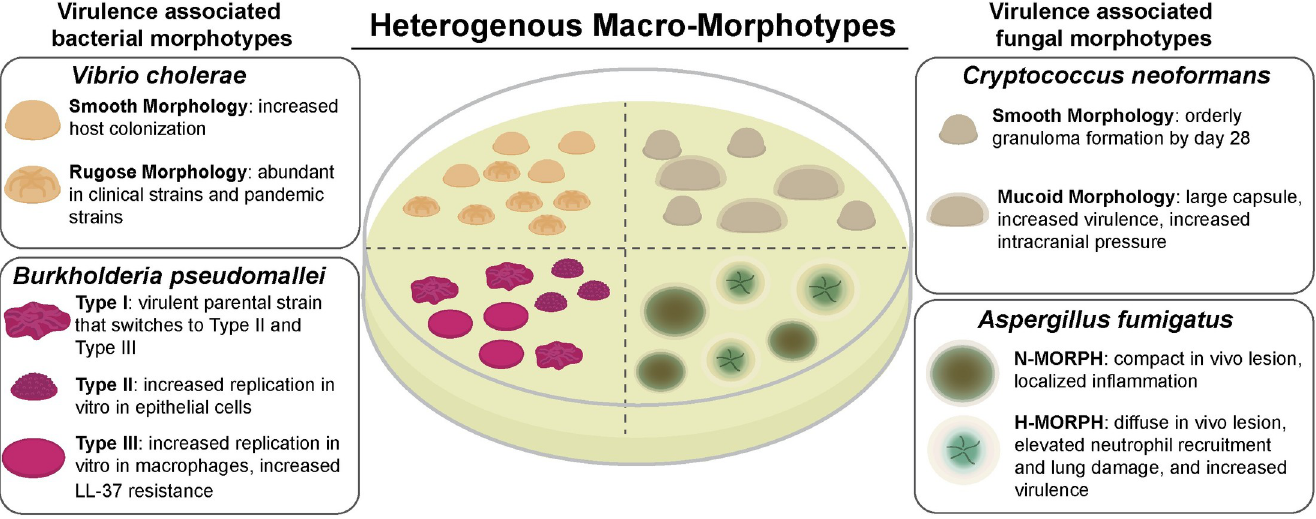
Fig 2. Virulence-associated macroscopic morphotypes of bacteria and fungi. Image summary of specific microbial colony morphologies associated with clinical isolation, host–pathogen interactions, and disease outcomes for bacteria ( V . cholerae and B . pseudomallei ) and fungi ( A . fumigatus and C . neoformans ) discussed in the text. H-MORPH, hypoxia-locked morphotype; LL-37, human cathelicidin family antimicrobial peptide; N-MORPH, normoxia-locked morphotype.